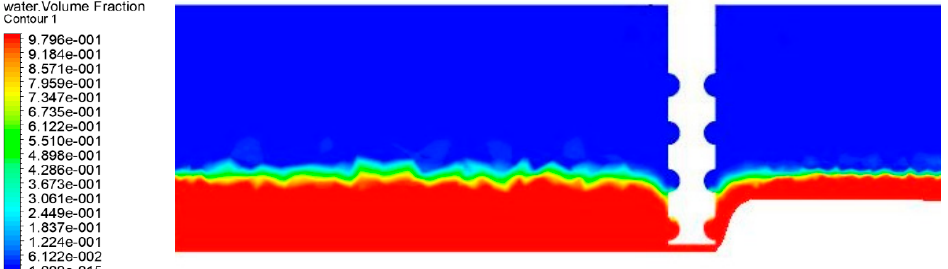
Figure 7. Gas distribution in the micro-machining gap.